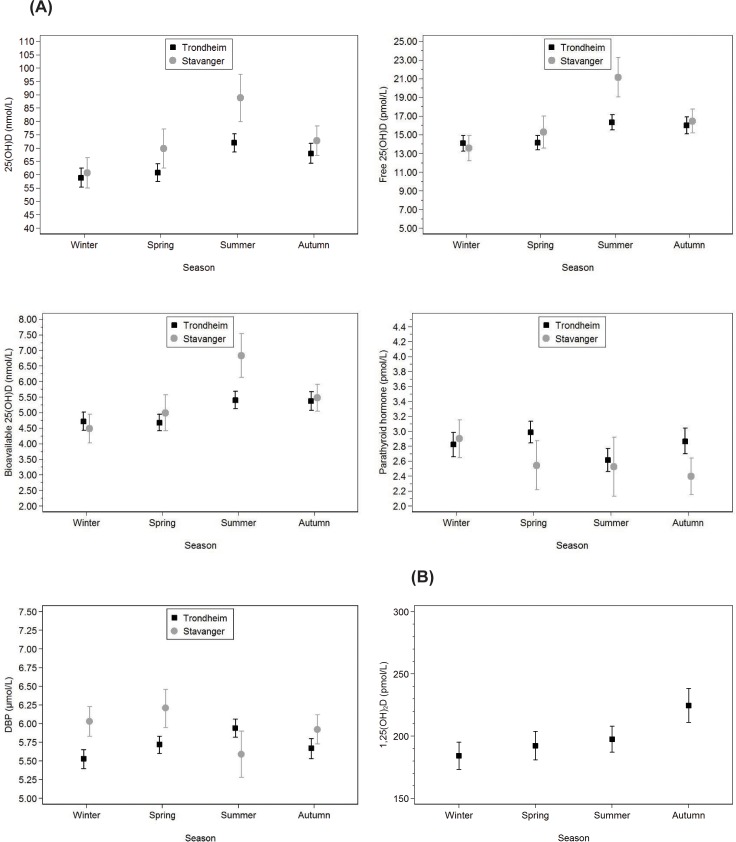
Seasonal variation of serum measures in second trimester.(A) Seasonal variation of serum total, free and bioavailable 25(OH)D, PTH and DBP in second trimester. (B) Seasonal variation of serum 1,25(OH)2D in second trimester, in a sub-analysis including 250 women living in Trondheim, Norway. Solid squares represent women living in Trondheim, Norway (latitude 63°N) and grey dots represent women living in Stavanger, Norway (latitude 58°N). Vertical lines represent 95% confidence intervals. A multivariable linear regression analysis was used, and separate analyses were performed for second and third trimester. In analyses involving 1,25(OH)2D, we used the pweight function in Stata to account for the sampling scheme (the inverse of the probability of an observation being selected into the sample). Abbreviations: PTH, parathyroid hormone; DBP, vitamin D-binding protein.